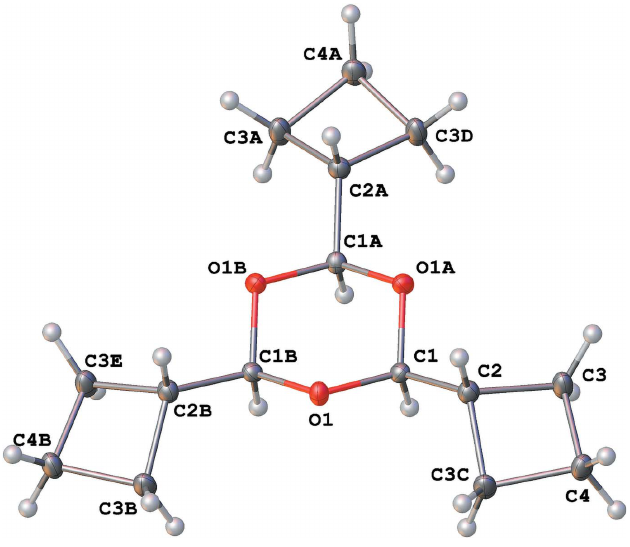
Figure 2 Molecular structure of 1 with displacement ellipsoids drawn at the 50% probability level. Symmetry codes: (A) y (cid:5) x , (cid:5) x , z; (B) (cid:5) y , x (cid:5) y , z ; (C) y , x , z ; (D) (cid:5) y + x , (cid:5) y , z ; (E) (cid:5) x , (cid:5) x + y , z .